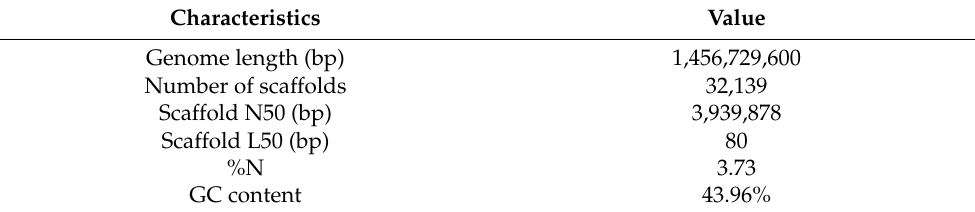
Table 1. Genome assembly and annotation